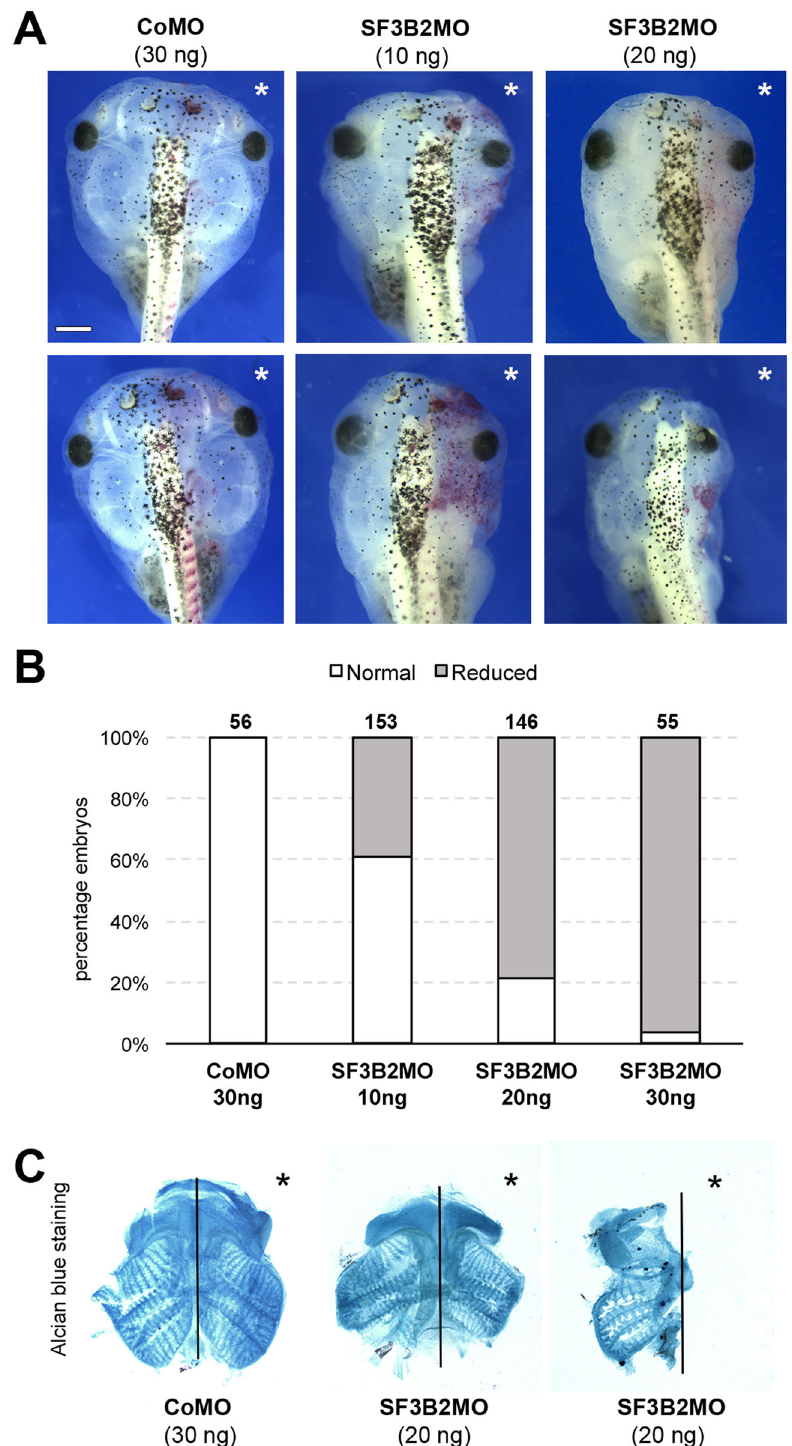
Fig. 4 Sf3b2 knockdown causes craniofacial defects in Xenopus tadpoles. A Gross morphology of the head of SF3B2MO- and CoMO-injected Xenopus tadpoles. The lineage tracer ß -galactosidase was again co-injected, with the injected side indicted by an asterisk. Dorsal views, anterior to top. The two rows show examples of the phenotype for each injection condition. Scale bar, 600 μ m. B The graph is a quanti fi cation of the results from three independent experiments. The number of tadpoles analyzed is indicated on the top of each bar. C Alcian blue staining of dissected craniofacial cartilages of CoMO (30 ng) and SF3B2MO (20 ng) injected tadpoles at stage 45. The injected side is indicated by an asterisk. The black lines indicate the midline. Source data are provided as a source data fi